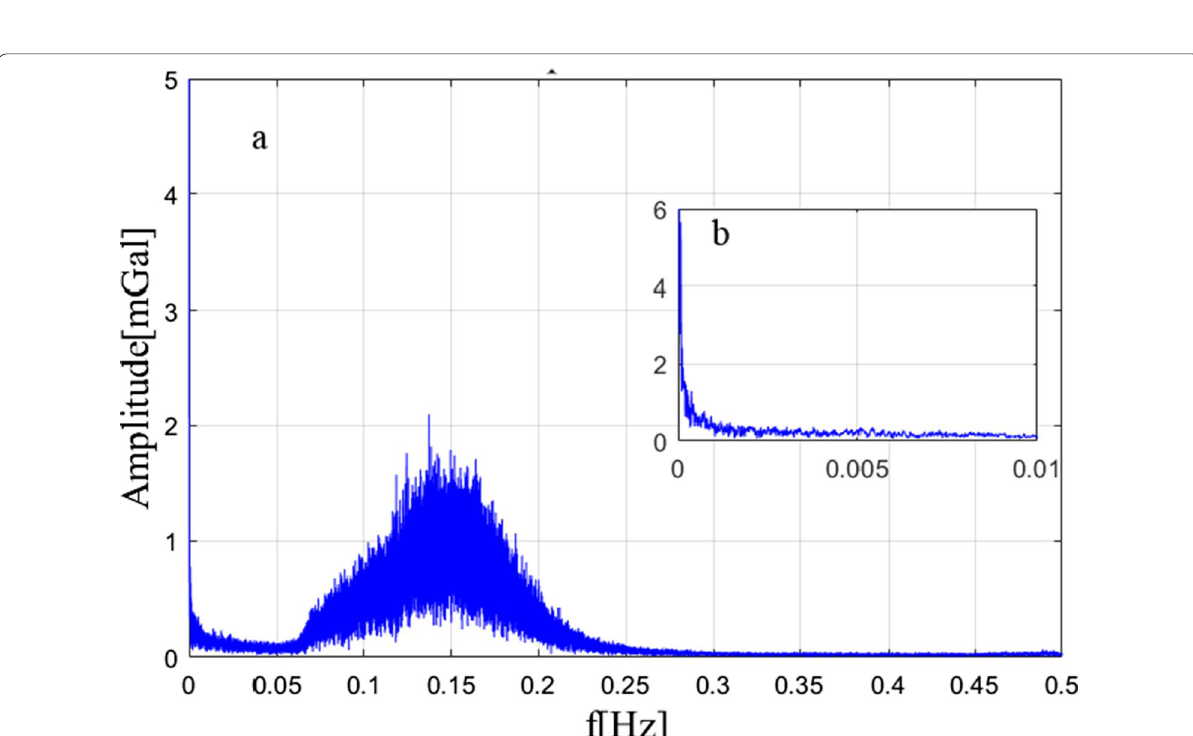
Fig. 11 a Fourier time–frequency analysis of the specific force of the entire voyage. b Enlarged view of the low-frequency band of